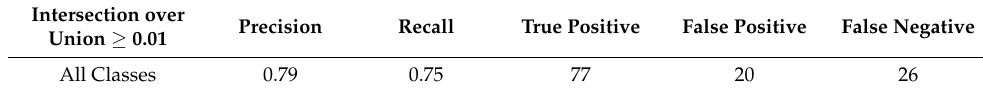
Table 3. Accuracy Assessment Report.